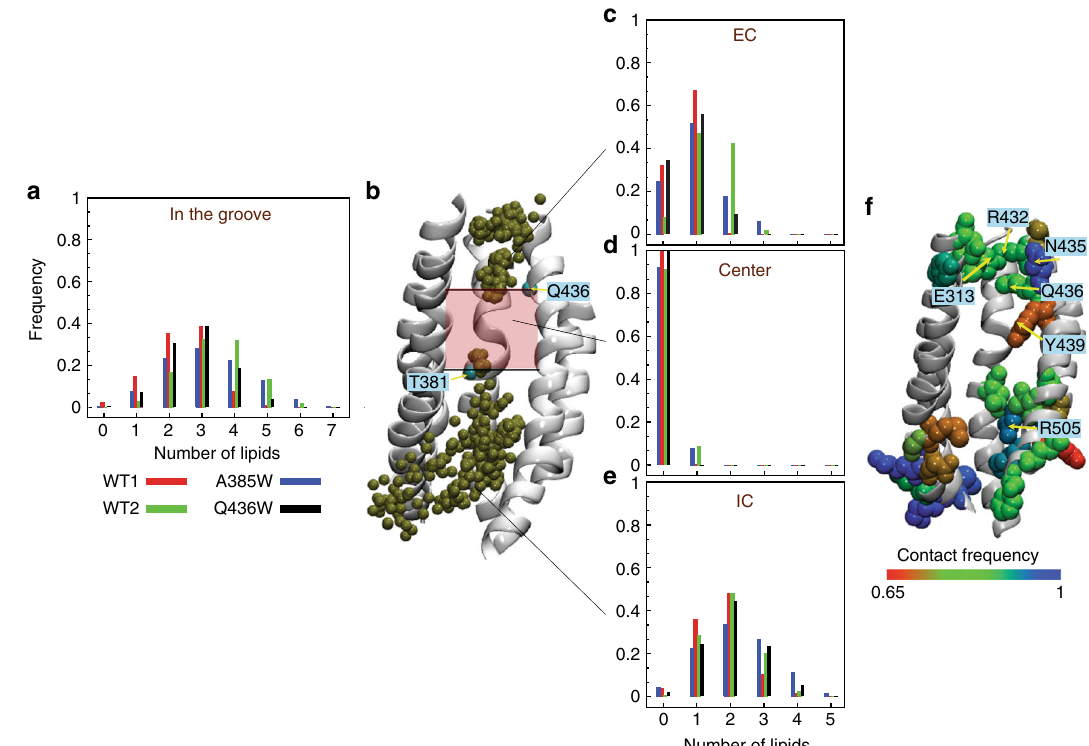
Fig. 4 Lipid headgroups transiently populate the hydrophilic groove of nhTMEM16. a The fraction of time (i.e., fraction of trajectory frames) a speci fi c number of lipid headgroups simultaneously occupy the groove in the WT1 (red), WT2 (green), A385W (blue), and Q436W (black) simulations (see 'Methods' for the de fi nition of the groove and its different regions). For each construct, the data shown is the average over the two protomers of nhTMEM16. b Snapshot of the nhTMEM16 (TM helices 3 – 7) from WT2 simulation illustrating coverage of the groove by lipid phosphorus atoms. Gold- colored spheres represent superposition of the phosphorus atom locations from the entire 4 µ s-long MD trajectory using a stride of 30 ns time-interval between the trajectory frames. The location of the central region of the groove devoid of lipids is indicated by the shaded rectangle between the thick black lines that indicate as well the z -axis positions of the C α atoms of residues T381 and Q436 (cyan spheres). c – e Same as in a only measured separately for three different compartments of the groove: EC side of the groove (in c ), center of the groove ( d ), and IC side of the groove ( e ). f nhTMEM16 structure (TMs 3 – 7) showing residues of the groove (in van der Waals and colored) that are in contact with lipid headgroup >65% of the time in the combined WT1 and WT2 trajectories (the data presented is the average over the two protomers of nhTMEM16). A lipid headgroup was considered in contact with a residue if the phosphorus atom of the lipid was within 7 Å of any atom of the residue (center-to-center distance was Table 2, 'Methods'). To learn how the pathway for lipid translo-